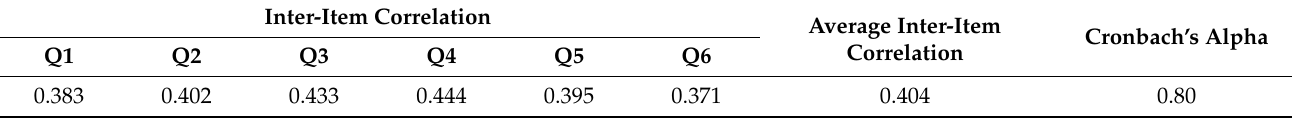
Table 1. Item analysis of the self-efficacy questions ( n =